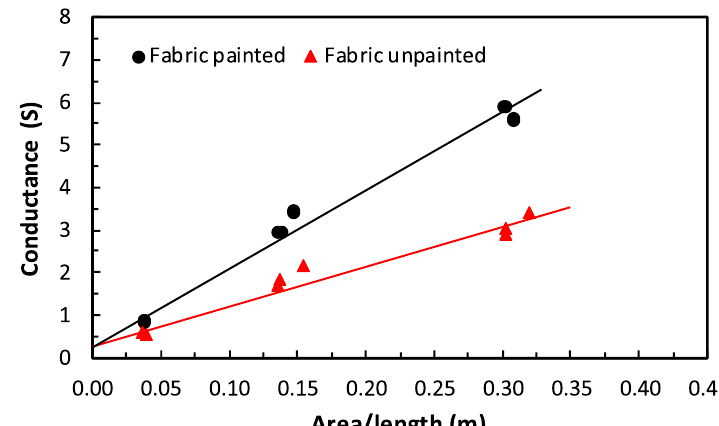
Fig. 7 Electrical contact resistance at interfaces in TTT direction of carbon/epoxy laminates